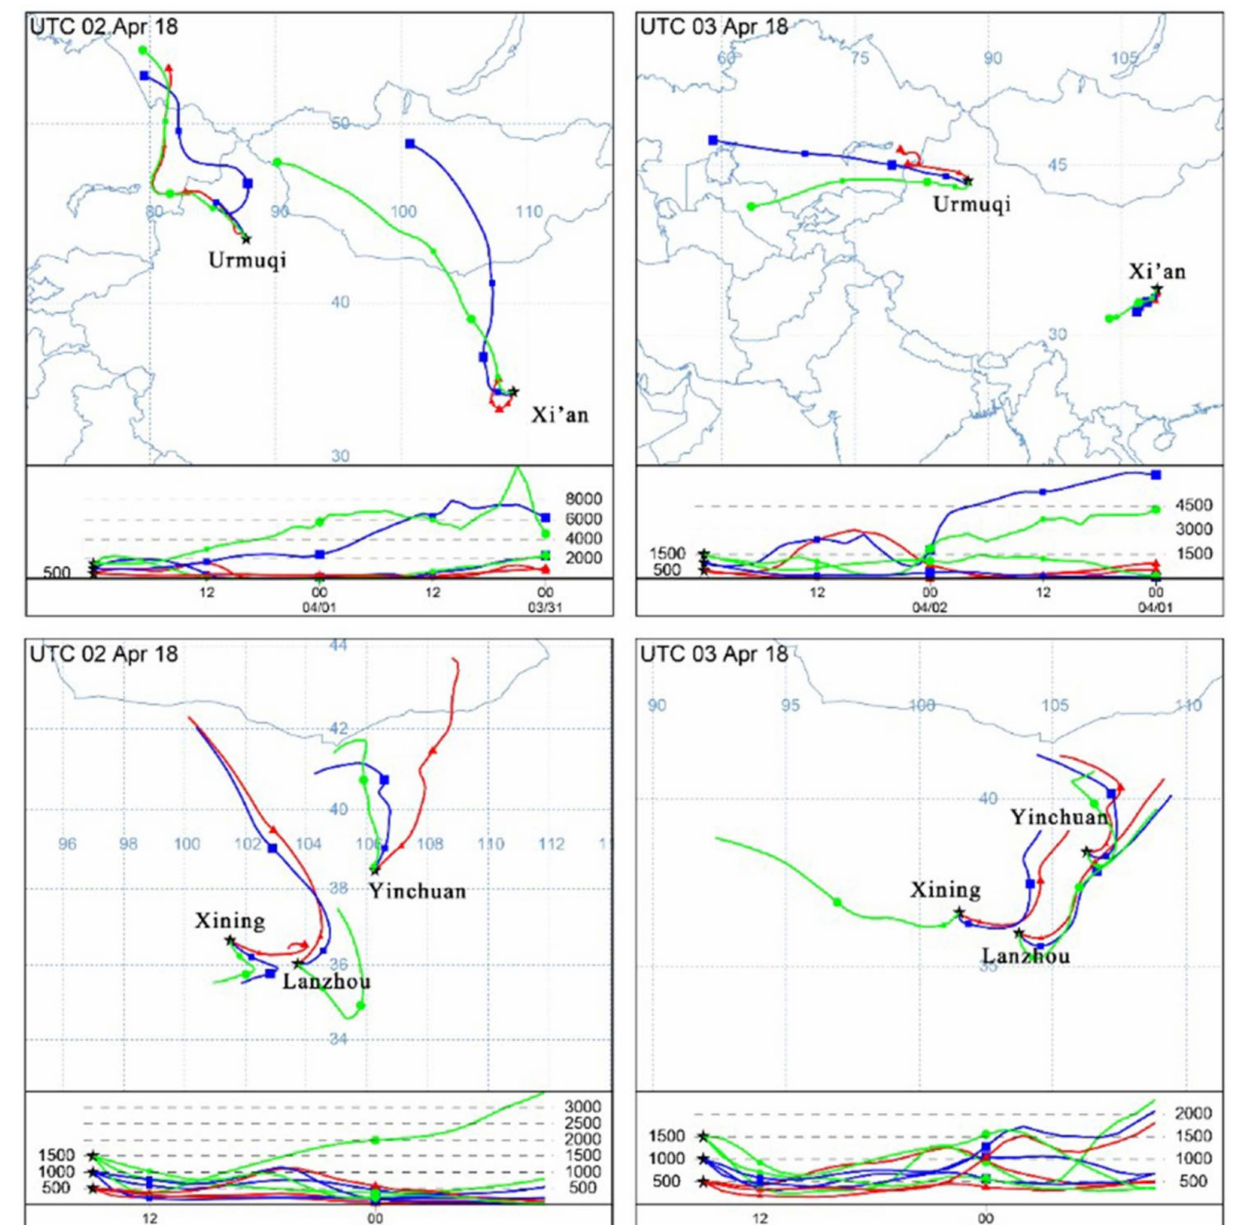
Figure 7. Simulation of dust backward trajectories in different cities of Northwest China for the period relevant to the sandstorm event in April 2018, for the case study